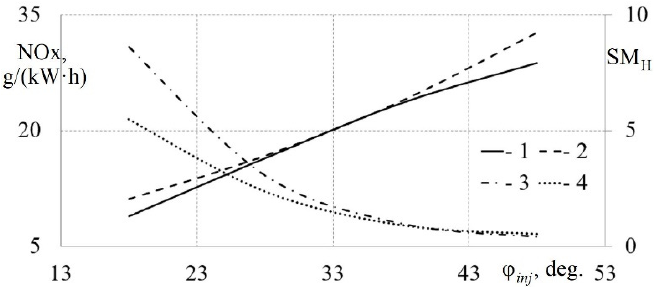
Figure 8. Dependences of the amount of NOx emissions and smokiness of the exhaust gases SMH on the fuel injection advance angle φ inj at different modes: 1—NOx = f ( φ inj ) at the nominal engine mode; 2—NOx = f ( φ inj ) at idle; 3—SM H = f ( φ inj ) in the nominal mode; 4—SM H = f ( φ inj ) at idle.